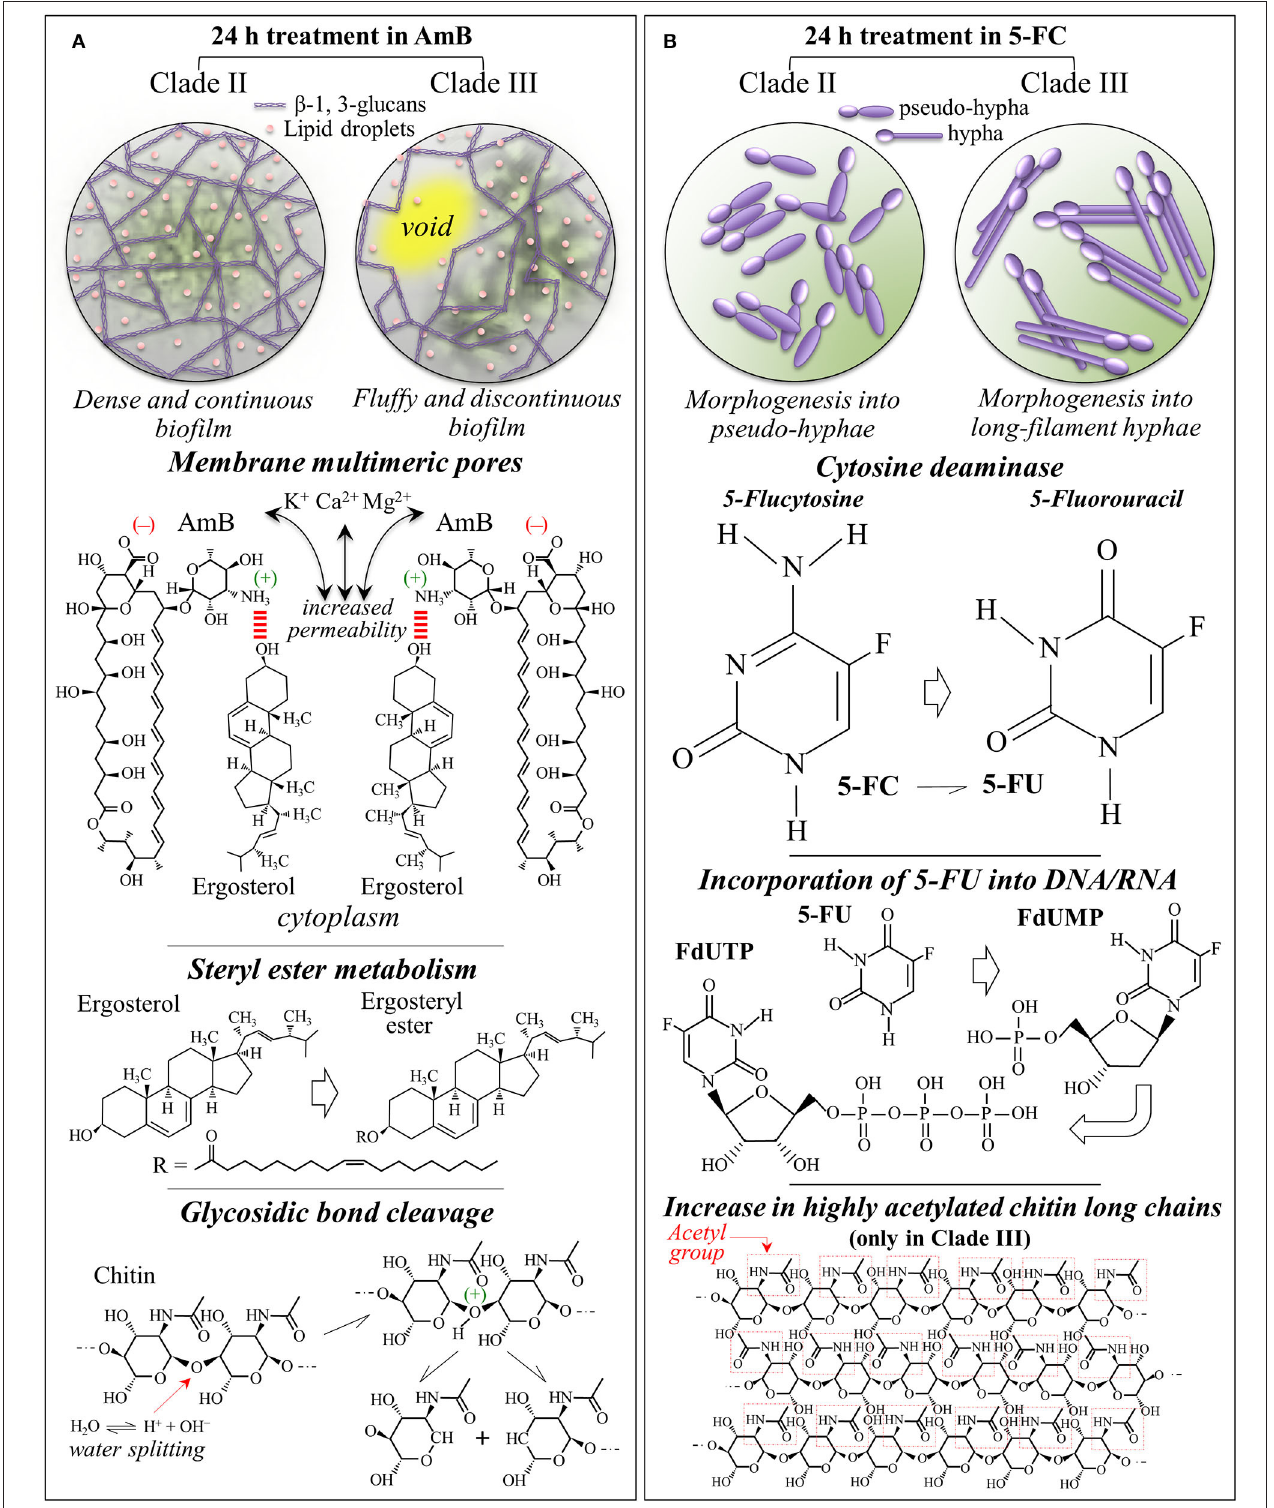
FIGURE 10 | Summary of the main spectroscopic findings, including the mechanisms of action and the metabolic behaviors of Clades II and III in response to (A) AmB and (B) 5-FC 24h treatments.